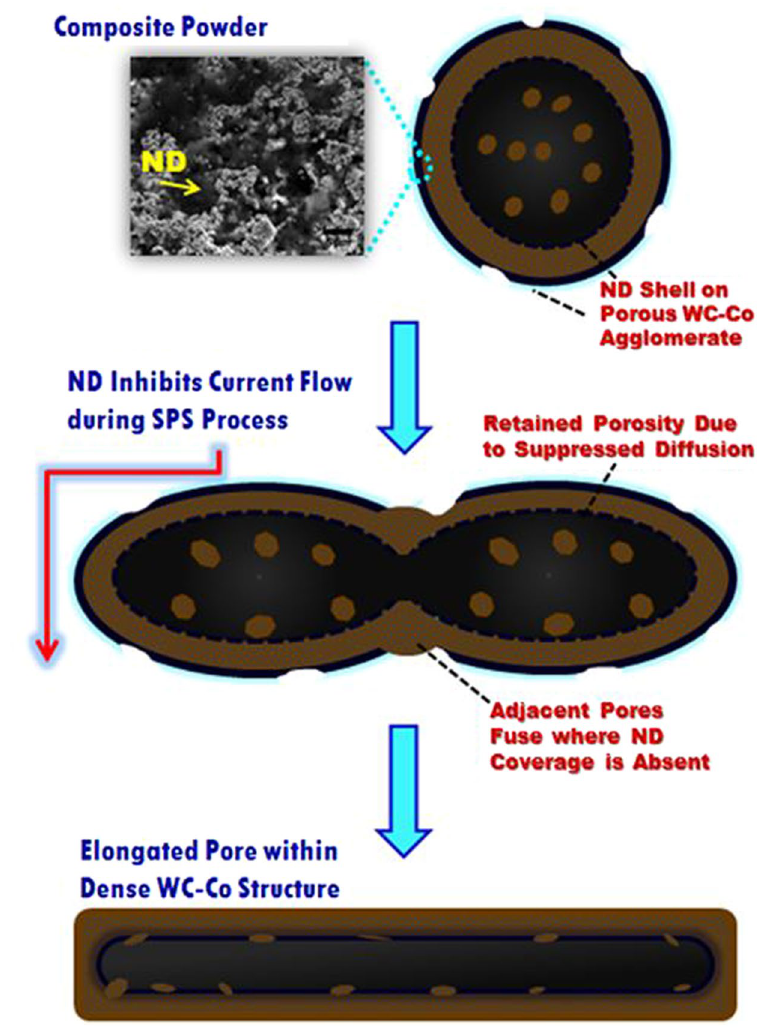
Figure 5. Schematic of formation mechanism of oriented high aspect ratio pores in